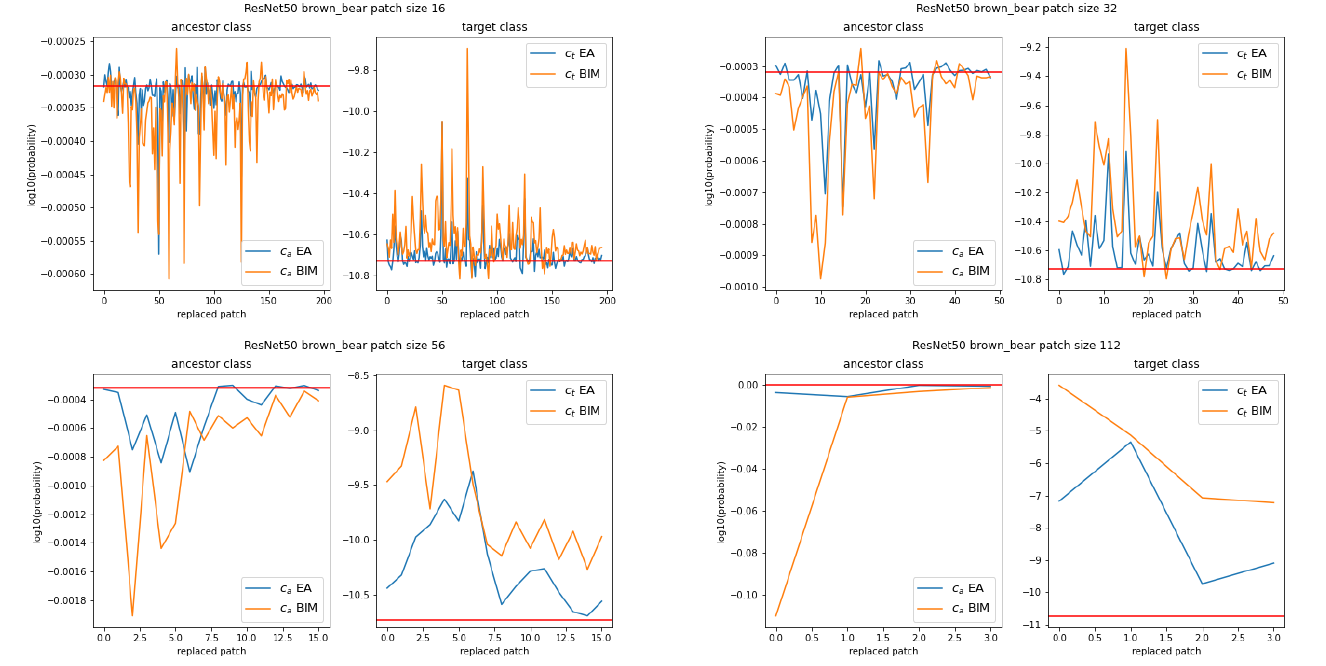
Figure 1. Single-patch replacement for A 4 and C = C 6 . The four pairs of graphs correspond to 5 patches with sizes of 16 × 16, 32 × 32, 56 × 56, and 112 × 112. Each pair represents the step-wise plot [ a ]) ( left graph) and of log ( o C [ t ]) ( right graph) for the EA (blue curve) and BIM (orange of log ( o C I I curve). The red horizontal line recalls the c a -label value ( left graph) or the c t -label value ( right graph) of A 4 with no replaced patch. 5